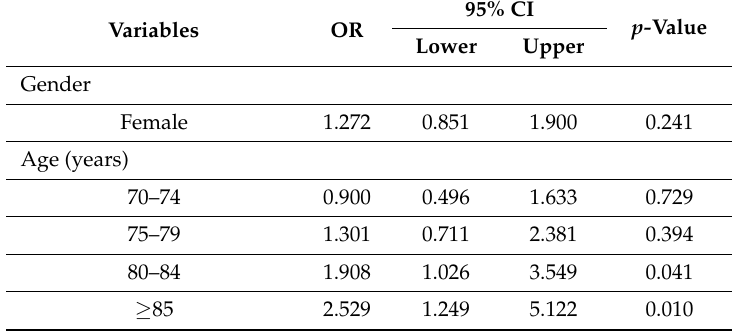
Logistic regression analysis for the demographic factors associated with MCI. CI: confidence